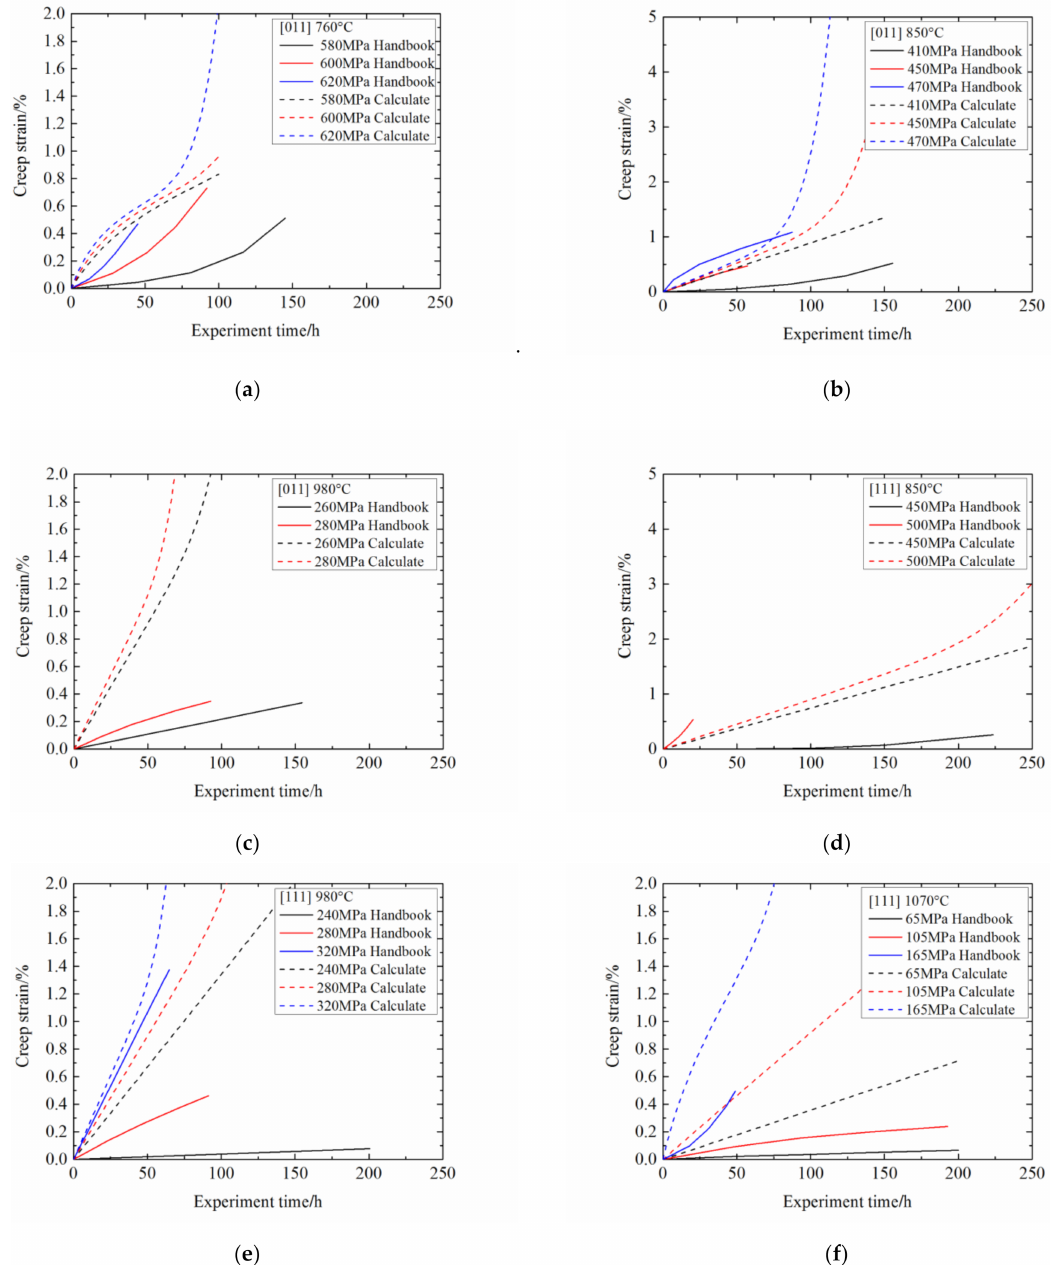
Figure 10. Nickel-based single crystal creep model predicted and experimental results. ( a ) [011] 760 ◦ C, ( b ) [011] 850 ◦ C, ( c ) [011] 980 ◦ C, ( d ) [111] 850 ◦ C, ( e ) [111] 980 ◦ C, ( f ) [111] 1070 ◦